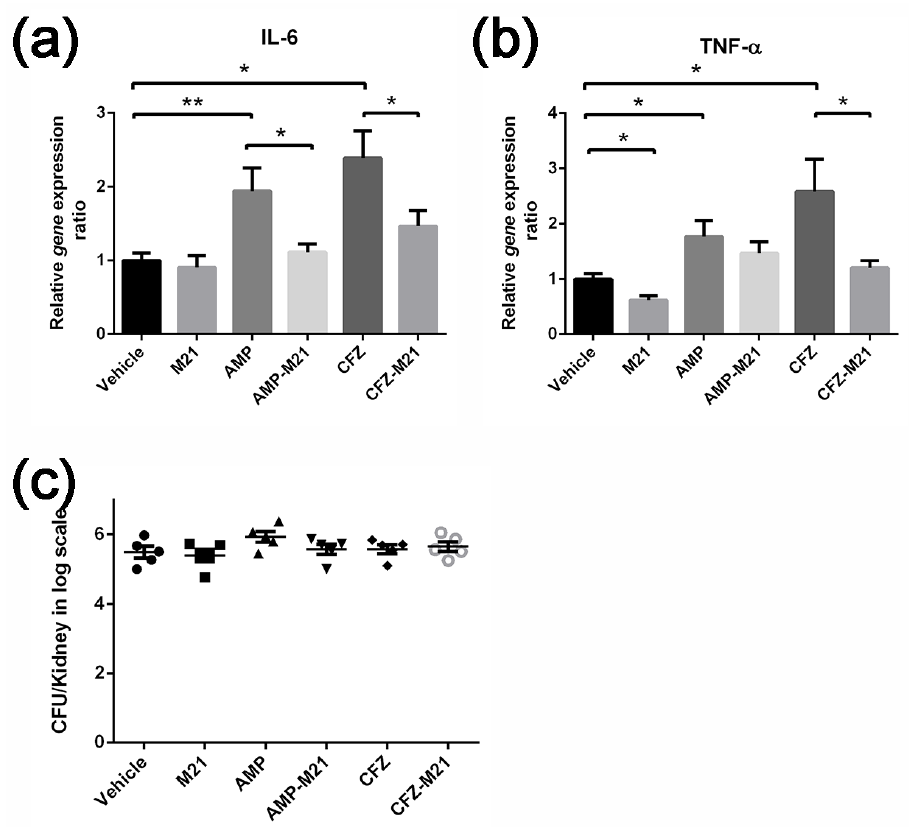
Figure 4. Cytokine gene expression in response to antibiotic-induced bacterial virulence. ( a , b ) q-PCR analysis of cytokine expression in mouse kidneys after bacterial infection and antibiotics treatment. Gene expression levels were relative to the hprt gene. ( a ) IL-6; ( b ) TNF- α ; ( c ) On day 2, ceftazidime and ampicillin in combination with M21 did not increase bacterial load in bacteremia model. Non-parametric tests were performed, and the treated groups were compared with the vehicle group. Data represent mean values ± SEM (* p < 0.05; ** p < 0.01).